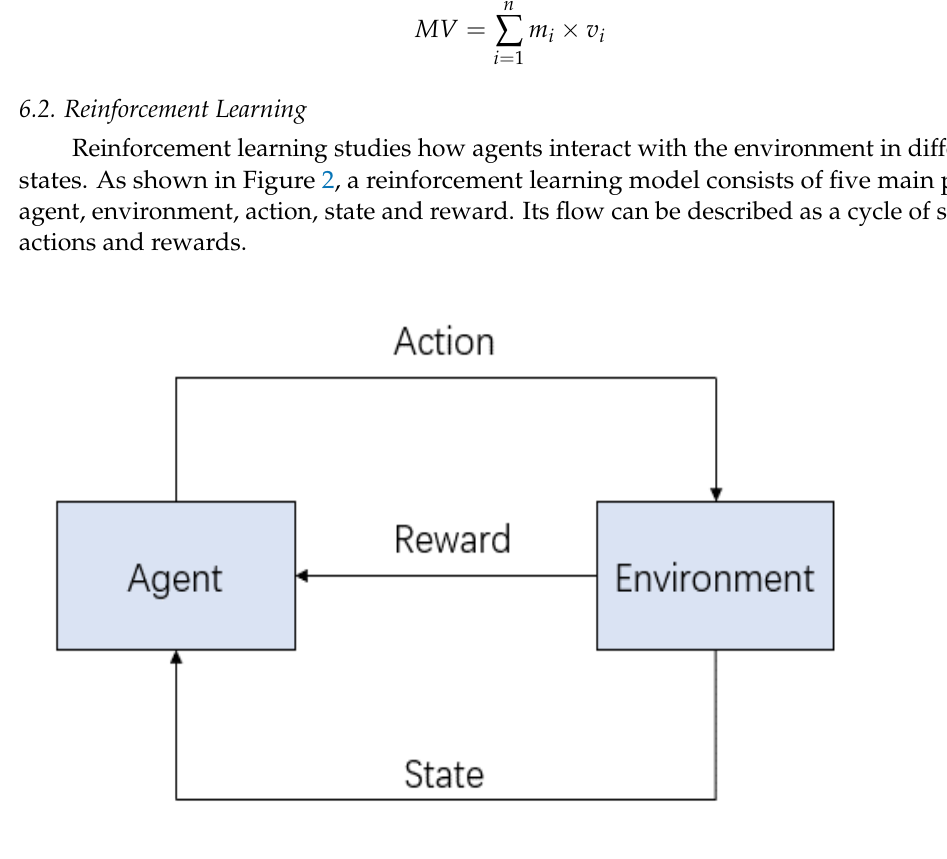
Figure 2. Illustration of the reinforcement learning